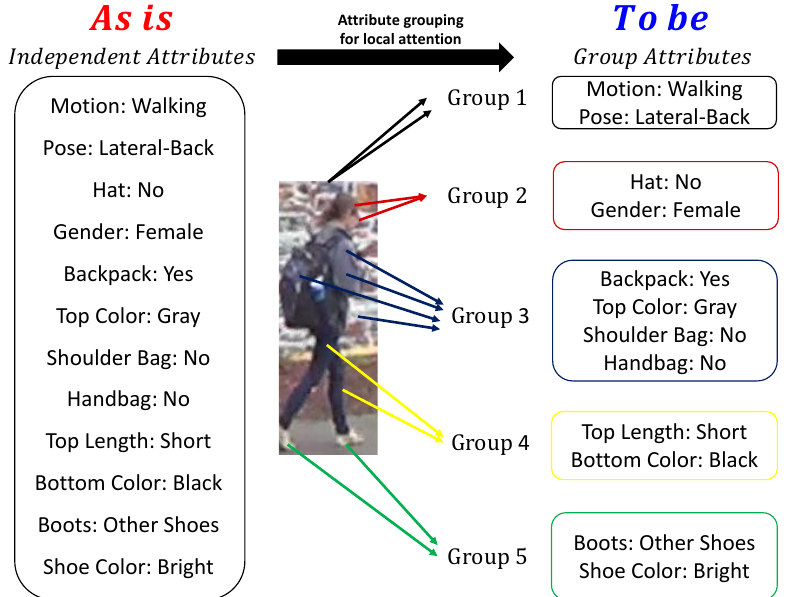
Figure 1. Attribute grouping for local attention. Physically-adjacent pedestrian attributes are grouped into one group. Group 1 is for attributes related to the entirety of a pedestrian. Groups 2, 3, 4, and 5 are for attributes related to the head, upper body, lower body, and feet of a pedestrian, respectively. The network focuses on the semantic information of the pedestrian such that it helps in recognizing pedestrian attributes occluded by